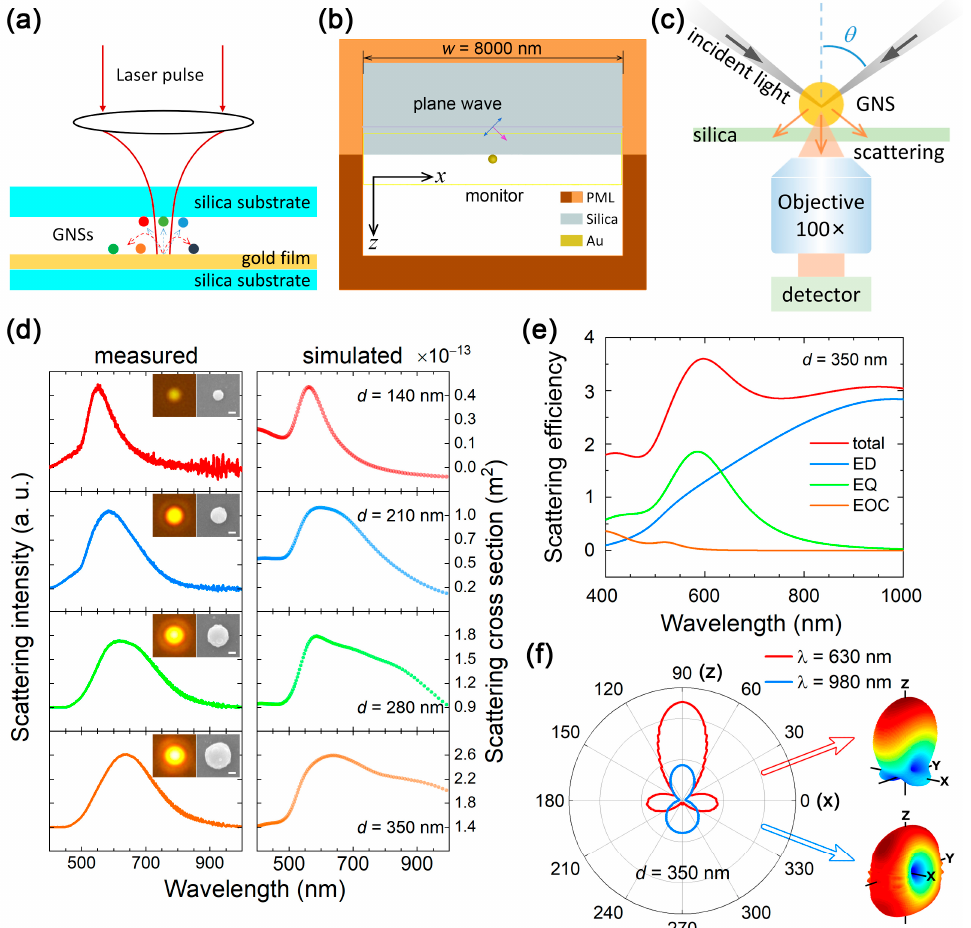
Figure 1. ( a ) Schematic showing the fabrication of gold nanospheres (GNSs) with different diameters on a silica substrate by using fs laser ablation. ( b ) Configuration used to simulate the far-field radiation from a GNS excited by an evanescent wave in the finite-difference time-domain (FDTD) simulations. ( c ) Schematic showing the illumination of a GNS placed on a silica substrate with white light at an incidence angle of θ ~58 ◦ , and the detection of the forward scattering light in a dark-field microscope. ( d ) Forward scattering spectra measured and simulated for GNSs with different diameters placed on a silica substrate. The SEM images of the corresponding GNSs and the coupled charge device (CCD) images of the scattering light are shown in the insets. The length of the scale bar is 100 nm in all cases. ( e ) The total scattering spectrum calculated for a GNS with d = 350 nm in free space based on Mie theory. The scattering has been decomposed into the contributions of electric dipole (ED), electric quadrupole (EQ), and electric octupole (EOC). ( f ) Two- and three-dimensional radiation patterns calculated for the GNS with d = 350 nm in free space at two wavelengths of 630 and 980 nm.